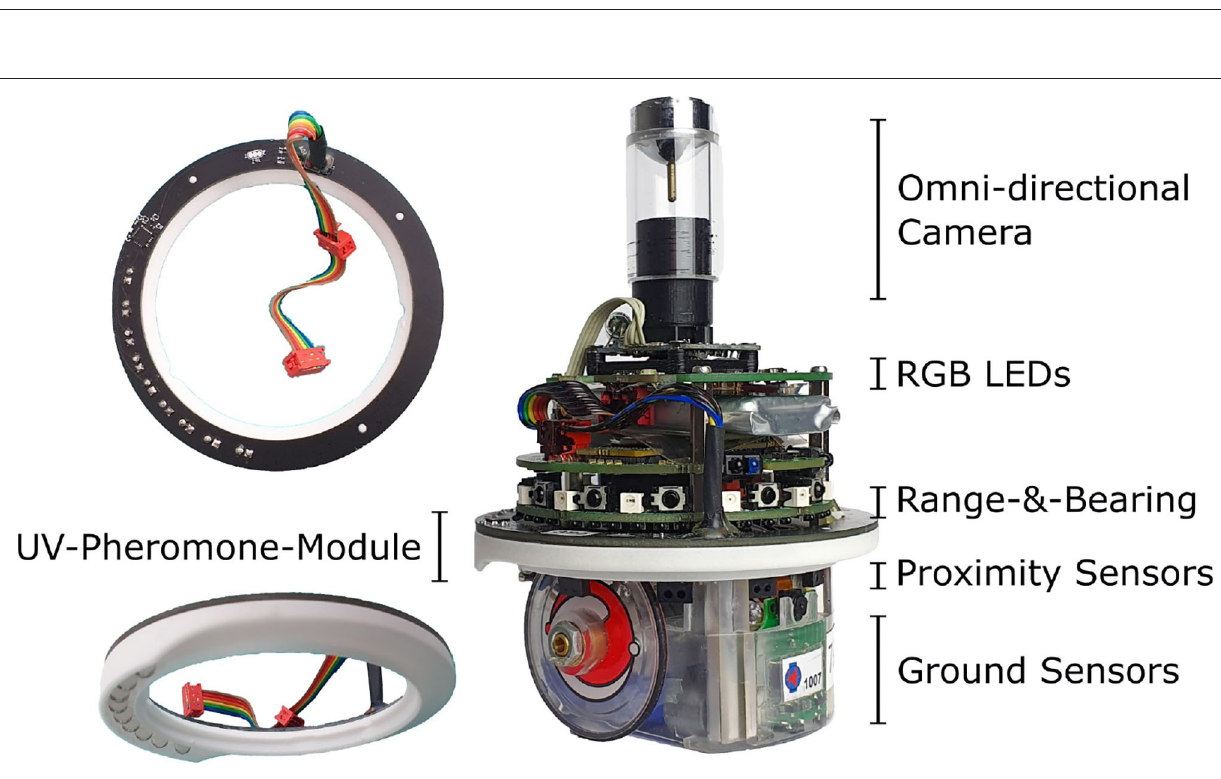
Frontiers in Robotics and AI | www.frontiersin.org